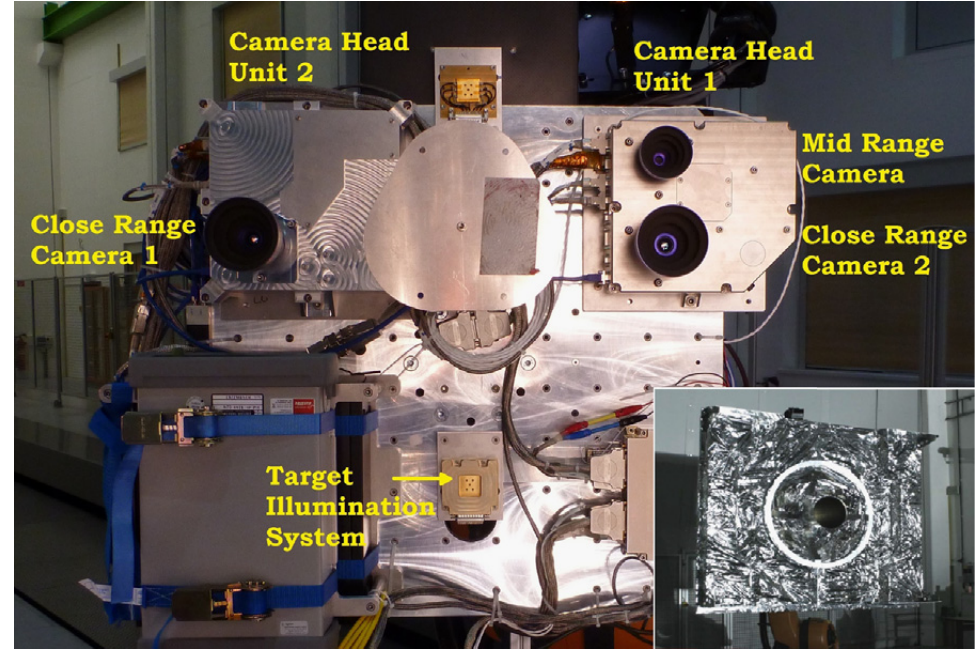
Figure 9. Setup for the VIBANASS test